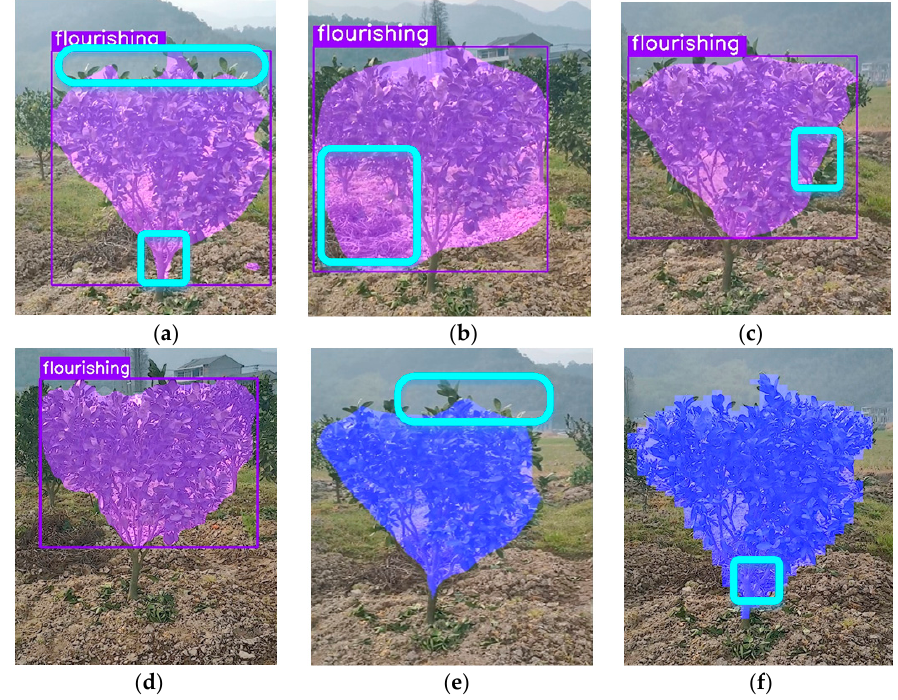
Figure 13. Comparison of test results among different algorithms: ( a ) BlendMask; ( b ) BoxInst; ( c ) CondInst; ( d ) MSEU R-CNN; ( e ) DeepLabv3; ( f ) UNet.